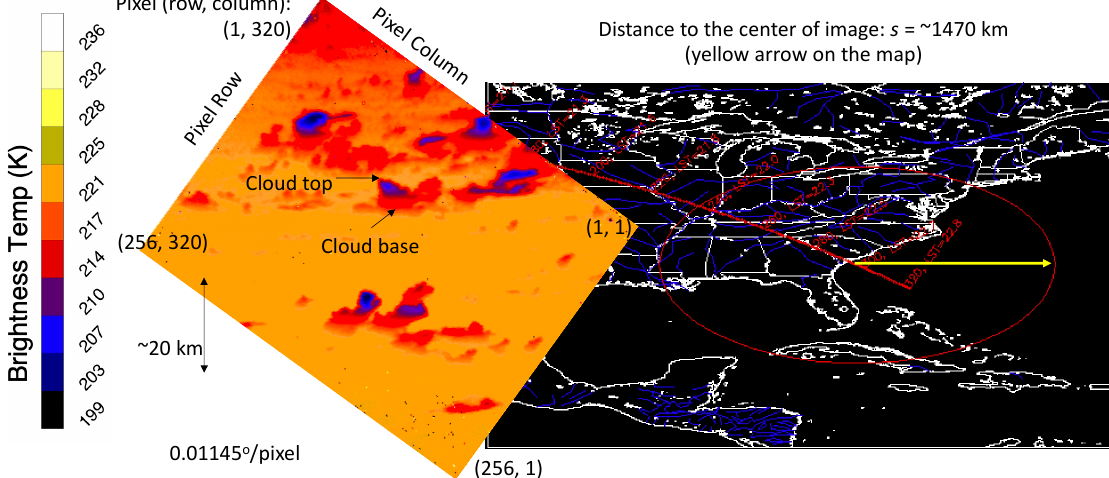
Figure 6. Nighttime CTI band1 image at a slant angle from the ISS pitch-up operation on 1 August 2019, when the CTI was viewing towards the North Atlantic from the U.S. East Coast as indicated by the yellow arrow. The pitch-up rate was approximately 0.089°/s, and the vertical resolution was ~290 m for a pathlength of ~1470 km. The CTI image is rotated to have atmospheric layers oriented in the horizontal direction and cloud tops upwards. In a slant view, cloud towers generally have a colder temperature at the top than at the bottom. A ~20 km scale is indicated to show the approximate vertical span of cloud towers. The red line is the ISS orbit track with local time labeled, and the red circle shows the range of the CTI’s field of view at this ISS pitch angle. The yellow arrow indicates the approximate pointing direction of the CTI.